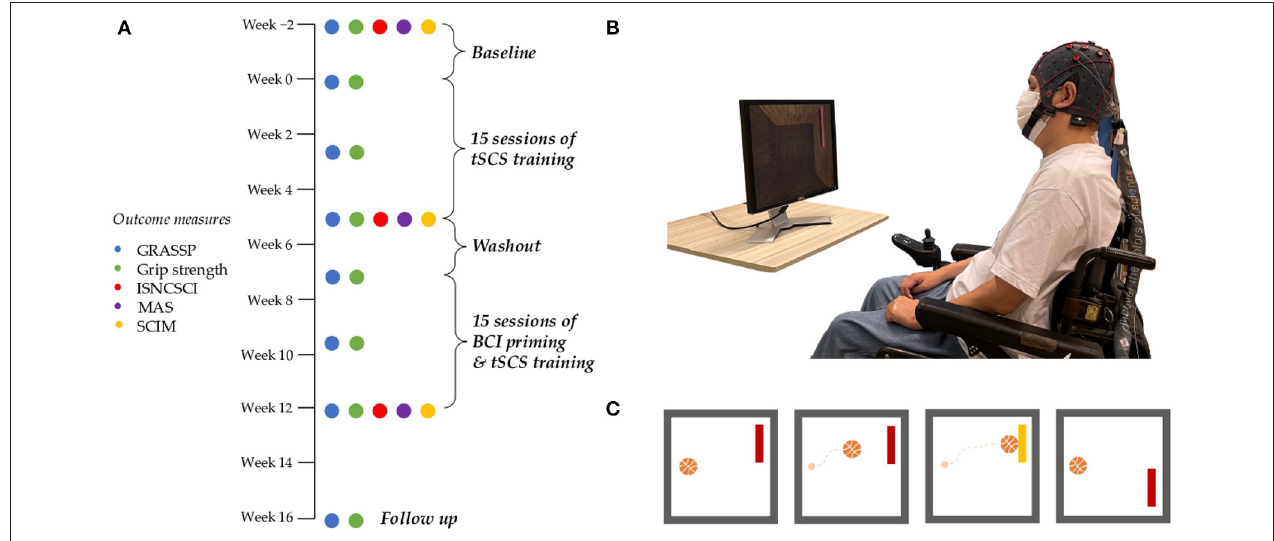
FIGURE 1 | Study protocol and BCI motor priming paradigm. (A) The 18 week study protocol showing primary and secondary outcome measures. (B) BCI priming setup. The participant wore an EEG cap and sat opposite a computer screen. The participant provided written consent that his photograph be used in any publications. (C) A simplified version of the BCI motor priming paradigm as displayed on a computer screen and observed by the participant. The participant’s objective was to attempt repetitive bimanual finger flexion/extension to guide a photo-realistic basketball to a target. The ball moved horizontally at a constant rate. Vertical displacement was influenced by the participant’s EEG and his ability to engage with the priming